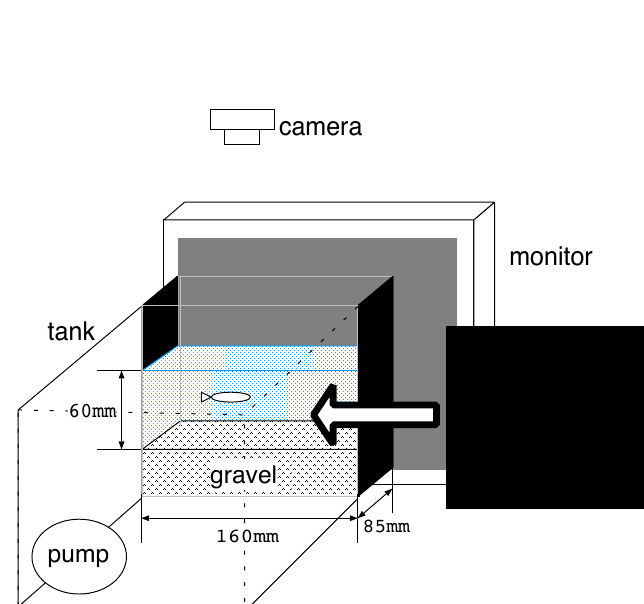
Figure 2: Experimental